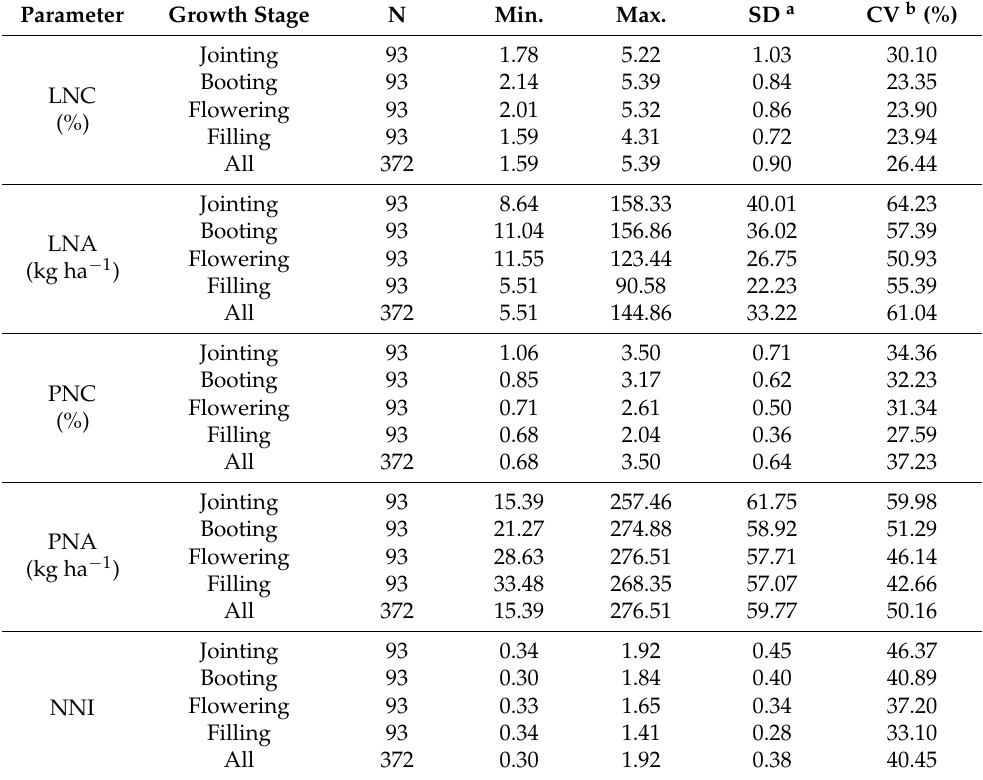
a SD indicates the standard deviation of the mean. b CV indicates the coefficient of variation